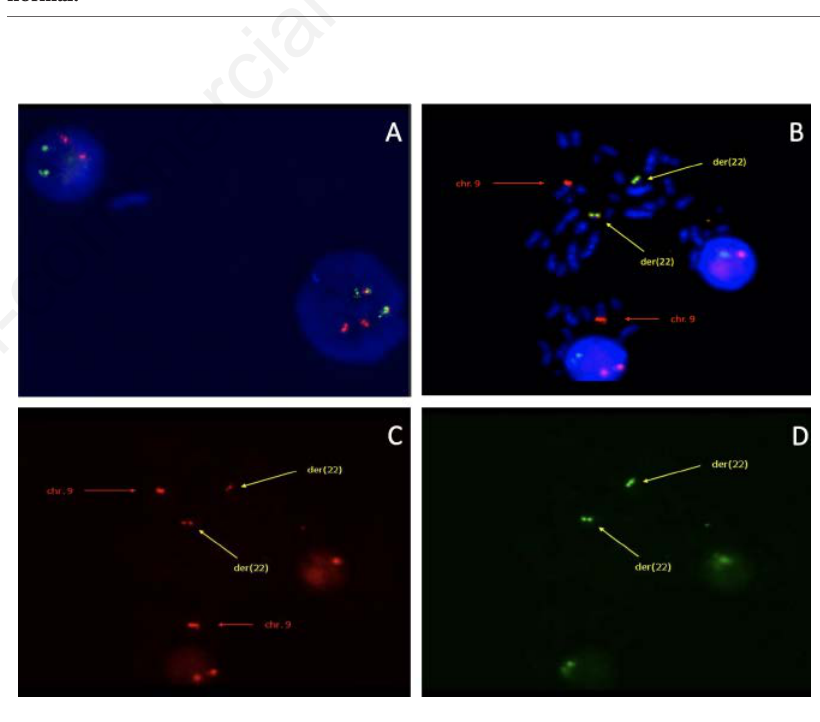
Figure 2. A) FISH on interphase cells from peripheral blood hybridized with locus spe- cific probe LSI BCR/ABL1 Dual Color/Dual Fusion (Vysis/Abbott, Illinois, USA), show- ing one normal nucleus with 2 red signals (ABL1 gene, 9q34.12) and two green signals (BCR gene, 22q11.23) and one abnormal nucleus with two red signals, and two fusion signals (red/green or yellow). B) FISH on metaphase cell, hybridized with locus specific probe XL BCR/ABL1 plus Translocation/Dual Fusion Probe (MetaSystems, Althlussheim, Germany) showing two red signals on chromosomes 9, two fusion signals on both chromosomes 22. C) Image B with spectrum orange filter. D) Image B with spec- trum green